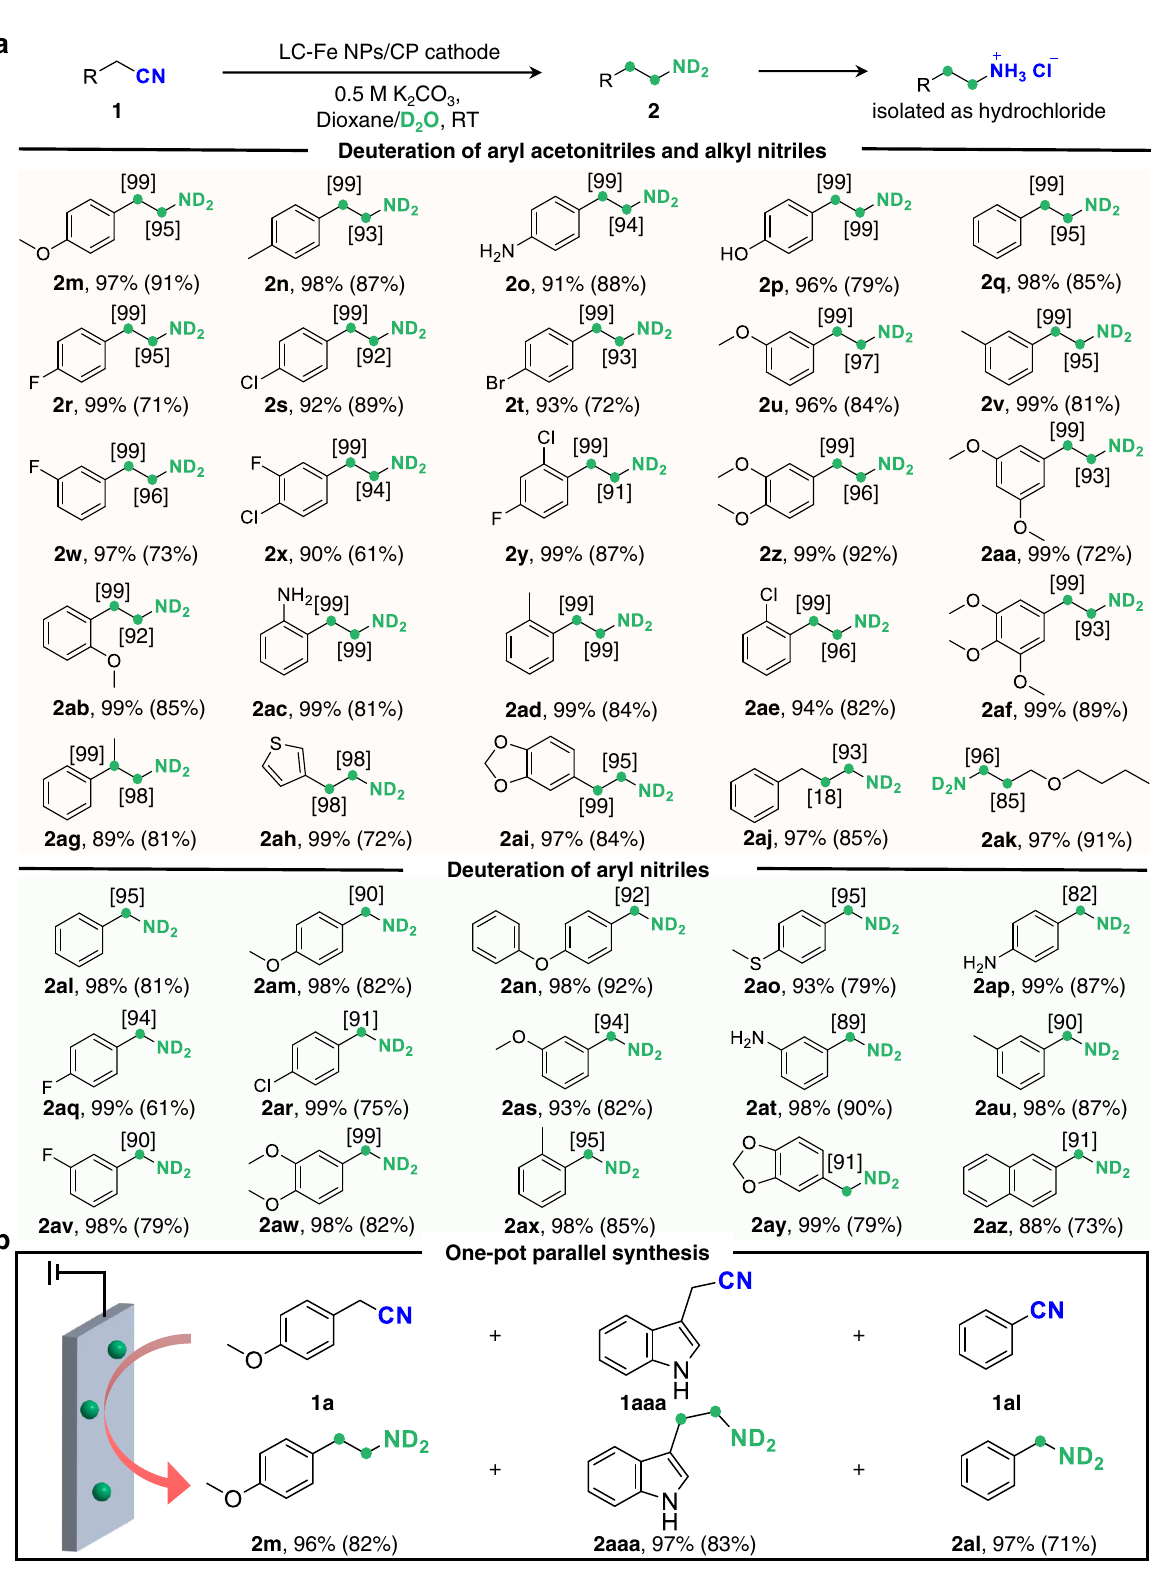
(3:1v/v, 8mL), LC-Fe cathode (working area: 1.0 cm 2 ), at − 1.2V, RT, 8h ( − 1.5V and − 1.4V are required for 2p and 2ae , respectively, and − 1.3V is required for 2x , 2ab , and 2ad ). b Parallelsynthesisofmultiple α , β